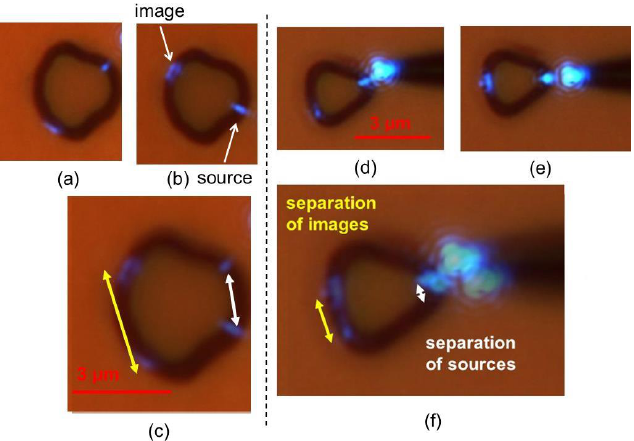
Figure 3. Experimental testing of image magnification at λ = 488 nm of two fisheye lenses with different M = R 1 / R 2 ratio: ( a , b ) Original magnified images obtained at different source positions. The location of image and source are indicated by the arrows. ( c ) Digital overlap of the images in (a) and (b) indicates that image magnification is close to the design value M = 2. ( d , e ) Similar original images and ( f ) the digital overlap image obtained with a different magnifying lens designed for M = 3.